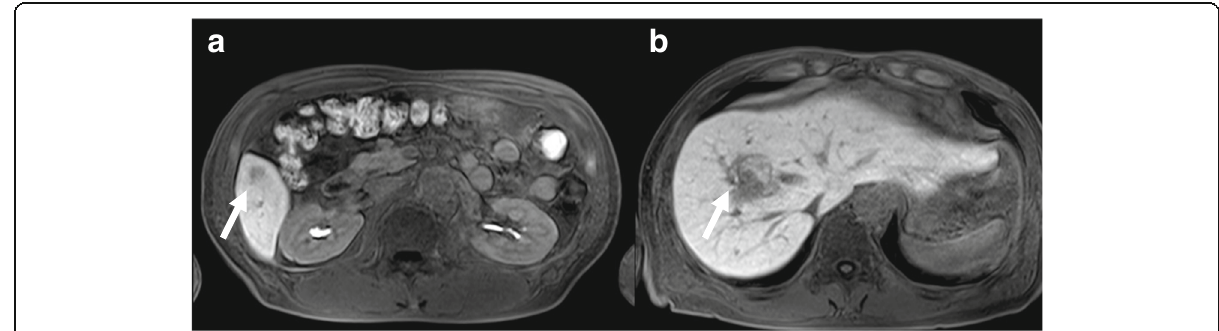
Fig. 2 RI findings enhanced by Gadolinium-ethoxybenzyl-diethylenetriamine pentaacetic acid before surgery. Enhanced MRI revealed two tumors (arrows) located in a segment 8 and b segment